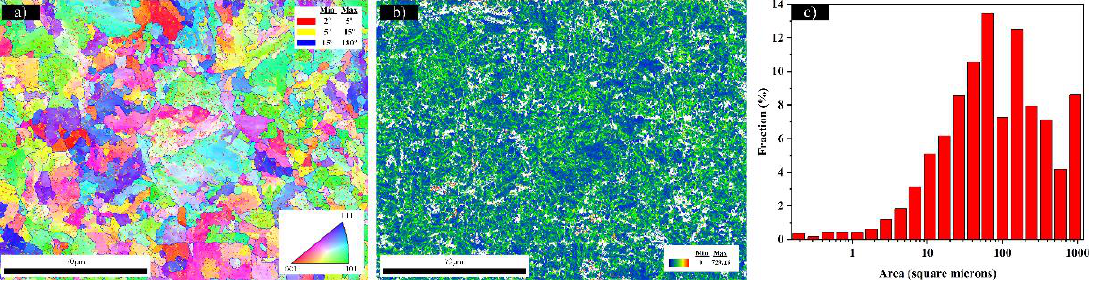
Figure 16. Microstructure information of sample C. ( a ) EBSD orientation map; ( b ) GND map; ( c ) grain area distribution.